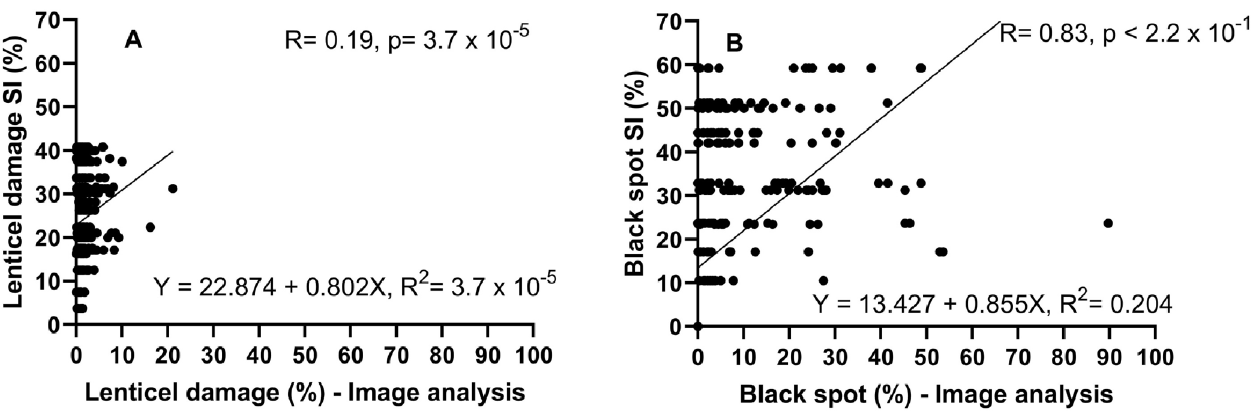
Figure 5. ( A ) Spearman’s correlation (rho = 0.19, p = 3.7 × 10 − 5 ) and linear regression (Y = 22.874 + 0.802X, R 2 = 0.025) between lenticel damage evaluation by image analysis (small spots) and the evaluation using hedonic scale expressed as SI. ( B ) Corresponds to the Spearman correlation (rho = 0.83, p < 2.2 × 10 − 16 ) and linear regression (Y = 13.427 + 0.855X, R 2 = 0.204) between black spot evaluated by image analysis (large spots) and the evaluation using hedonic scale expressed as SI. A total of 480 observations were used, obtained from both harvest stages and three evaluated orchards. Each point represents a condition (20 fruits per condition were evaluated).